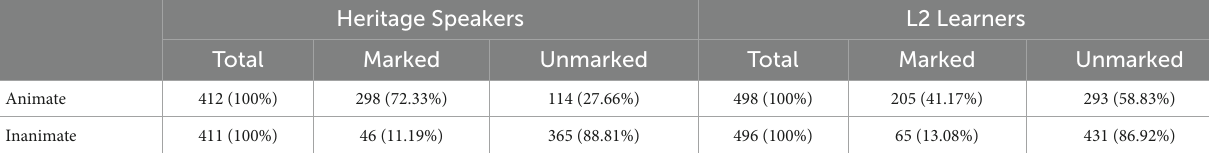
TABLE 4 Use or omission of DOM with animate and inanimate objects (elicitation task). Heritage